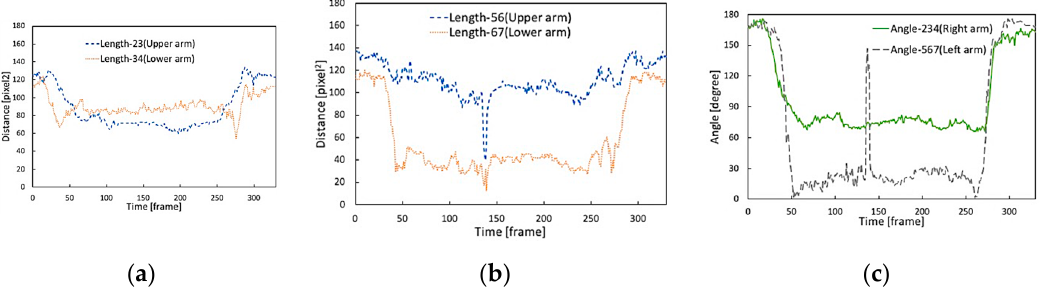
Figure 10. Arm’s length and angle of bending arms of subject 1 when taking photo. ( a ) Right upper and right lower arm’s lengths; ( b ) left upper and left lower arm’s lengths; ( c ) angles of right bending and left bending arms. In ( a , b ), vertical axis represents distance between joints (length) in pixel 2 . The horizontal axis indicates frame number it means time (in frames). In ( c ), the vertical axis represent angle in degree. The horizontal axis indicates frame number it means time (in frames).